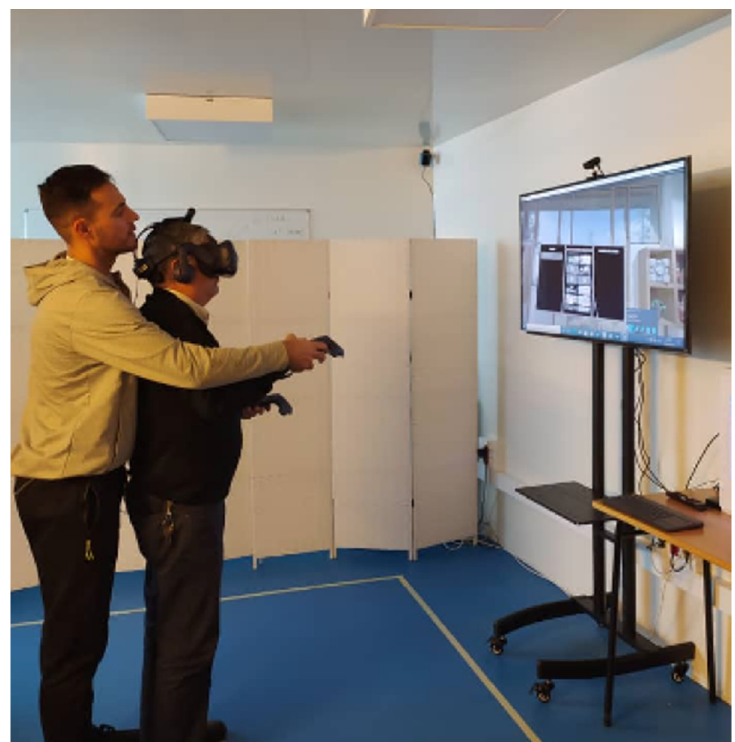
Figure 1. Participant during an individual session guided and supervised by a physiotherapist.